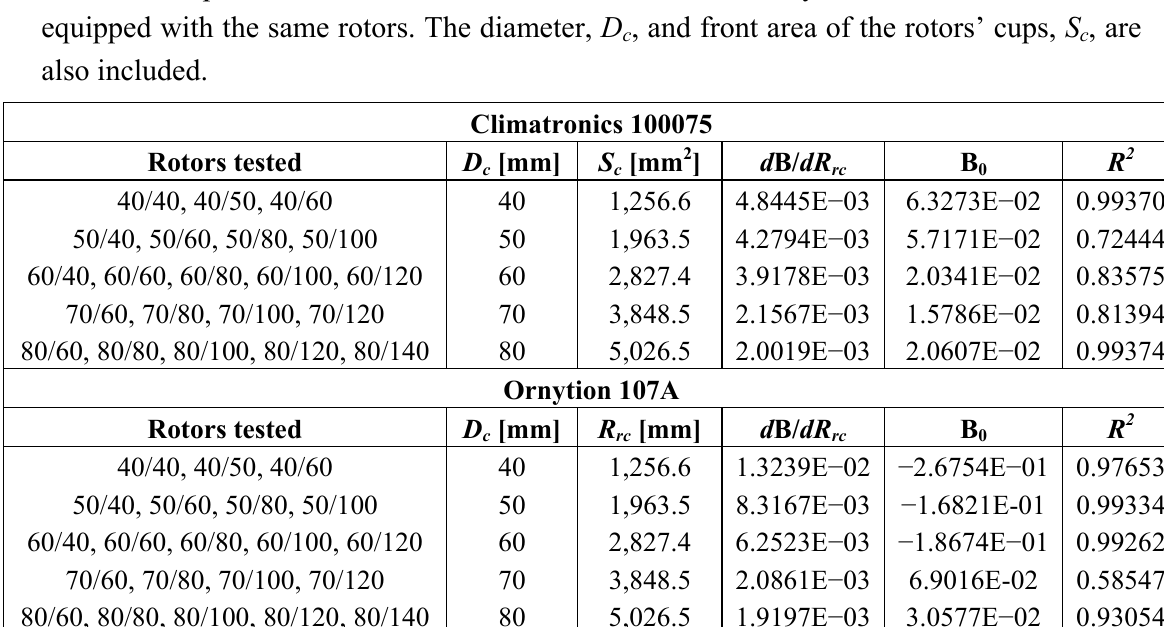
, offset, B , and correlation coefficient, R 2 ) of rc 0 , with regard to rc , and front area of the rotors’ cups, S , are c c